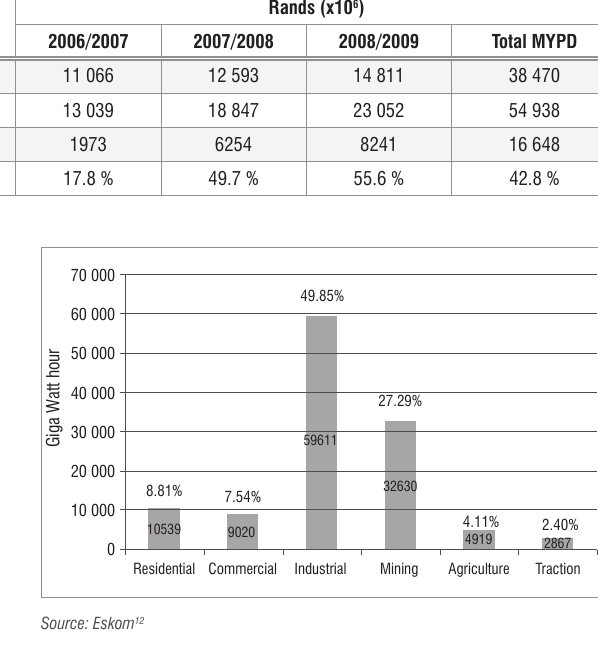
Local electricity sales by Eskom, per sector, in GWh.